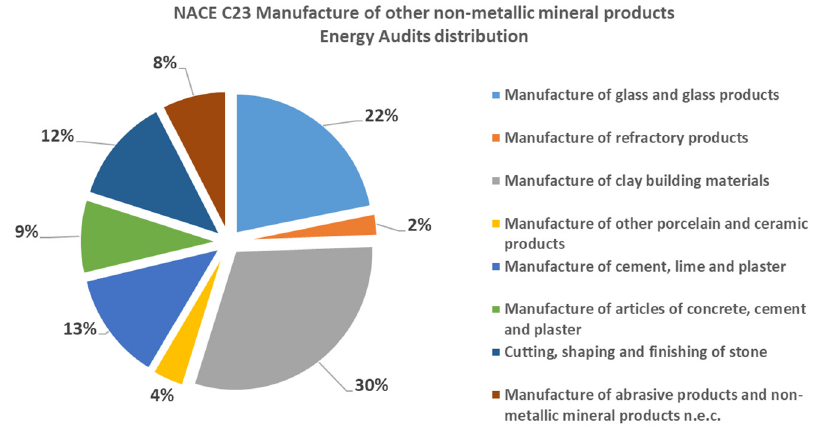
Figure 5. NACE C23 groups’ energy audit percentage distribution.